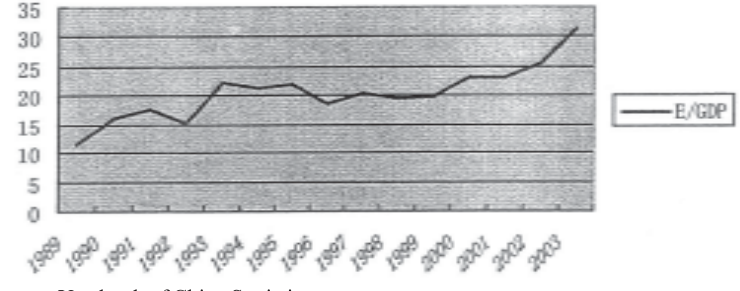
Figure 5 Ratio of Export to GDP in Chinese